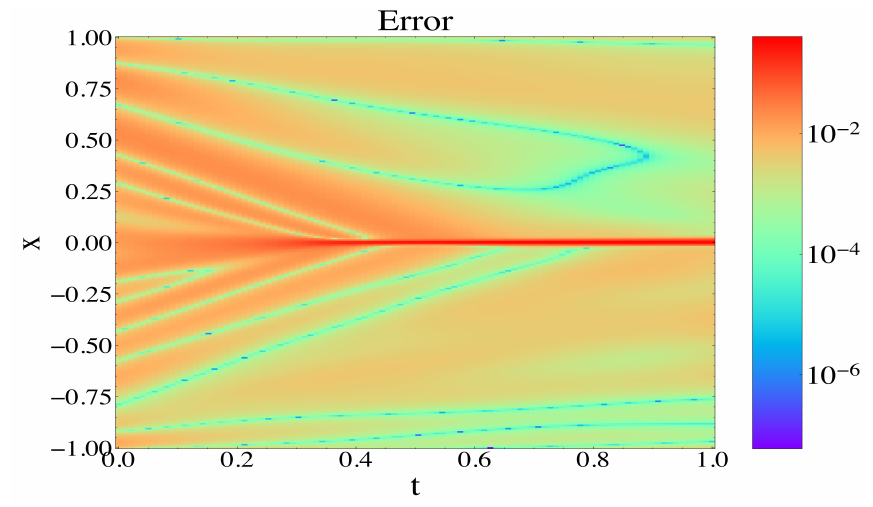
Figure 9. Burgers equation: error contour